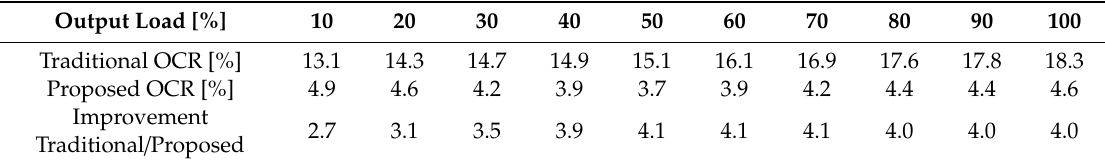
Table 4. Measurements of load percentage versus output current ripple percentage at input voltage of 110 V (OCR: output current ripple).